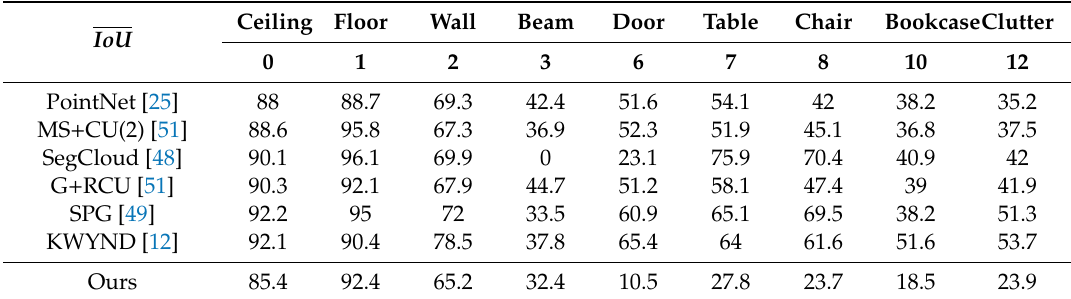
Table 9: Benchmark results of our semantic segmentation approach against best-performing deep-learning methods.